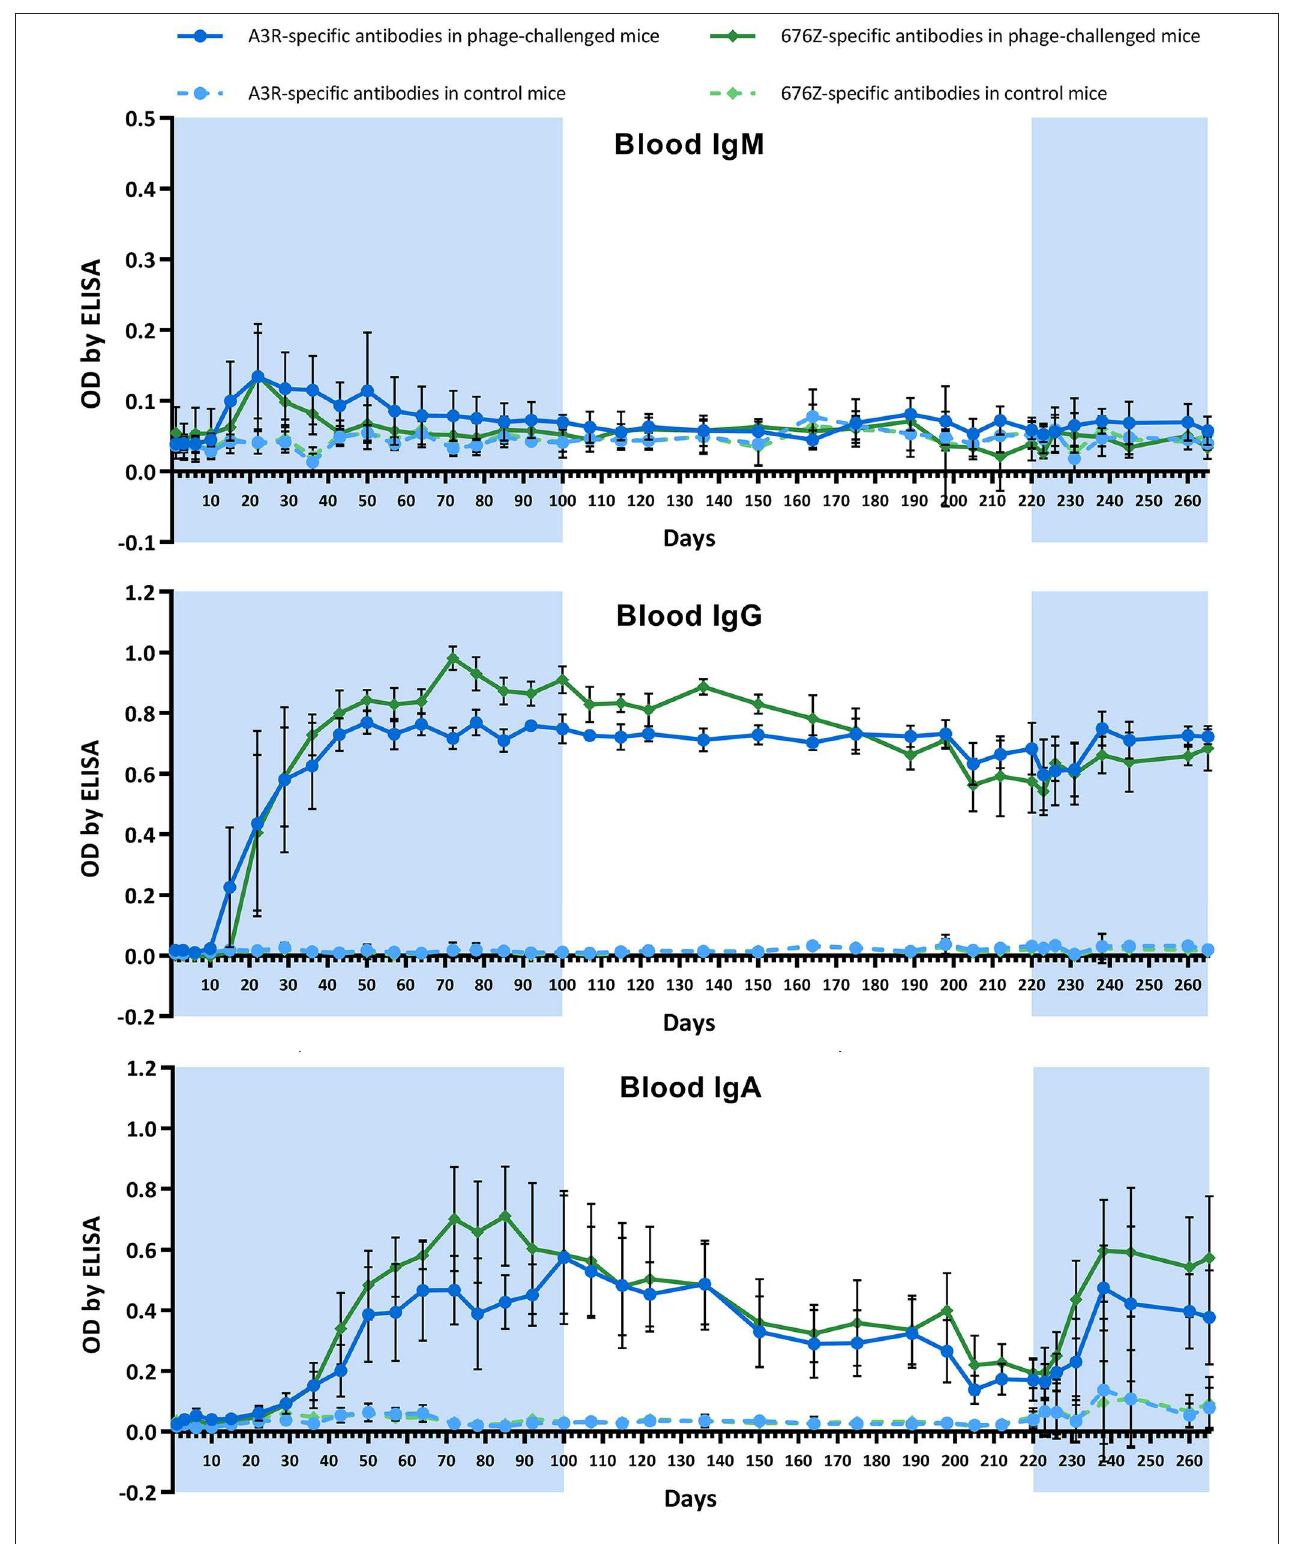
FIGURE 2 | Kinetics of phage-specific antibody production in blood of mice treated with phages A3R or 676Z. IgM, IgG, and IgA levels were evaluated by enzyme-linked immunosorbent assay (ELISA). Mice ( N = 6) were administered purified preparations of phages A3R or 676Z in drinking solution of the final